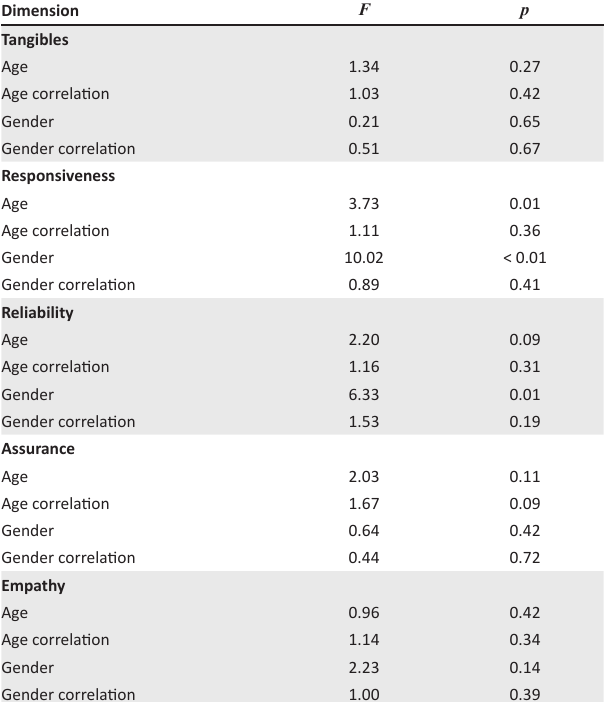
TABLE 2: Analysis of variance results per dimension across gender and age groups. Dimension